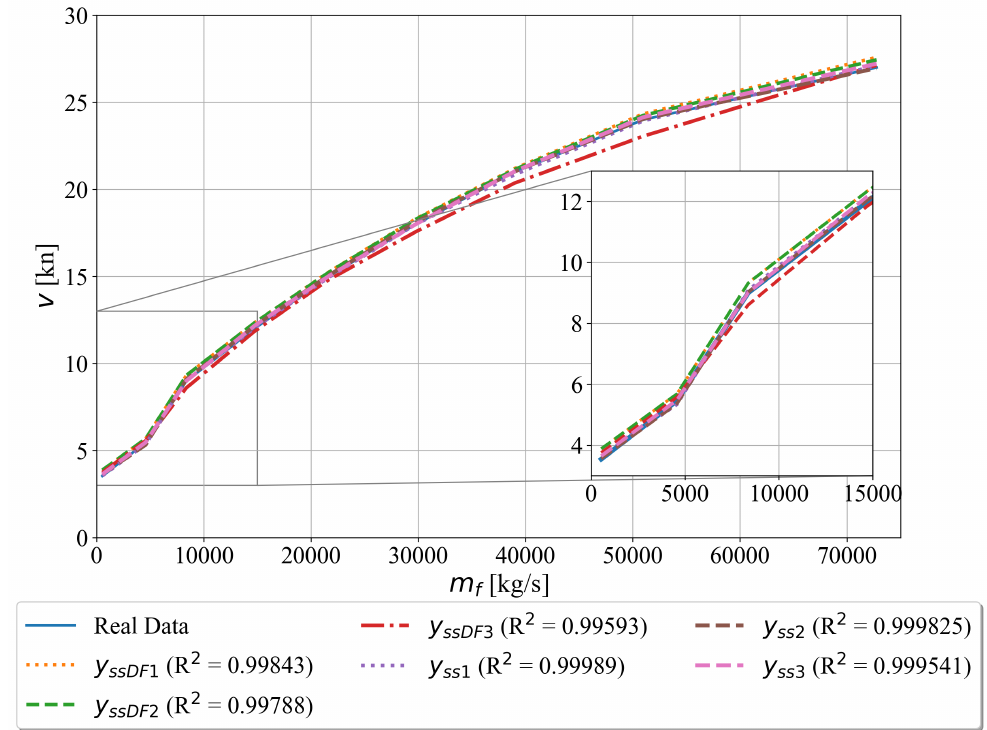
Figure 8. The Comparison of Estimated Ship Speed with Real Data Versus the Fuel